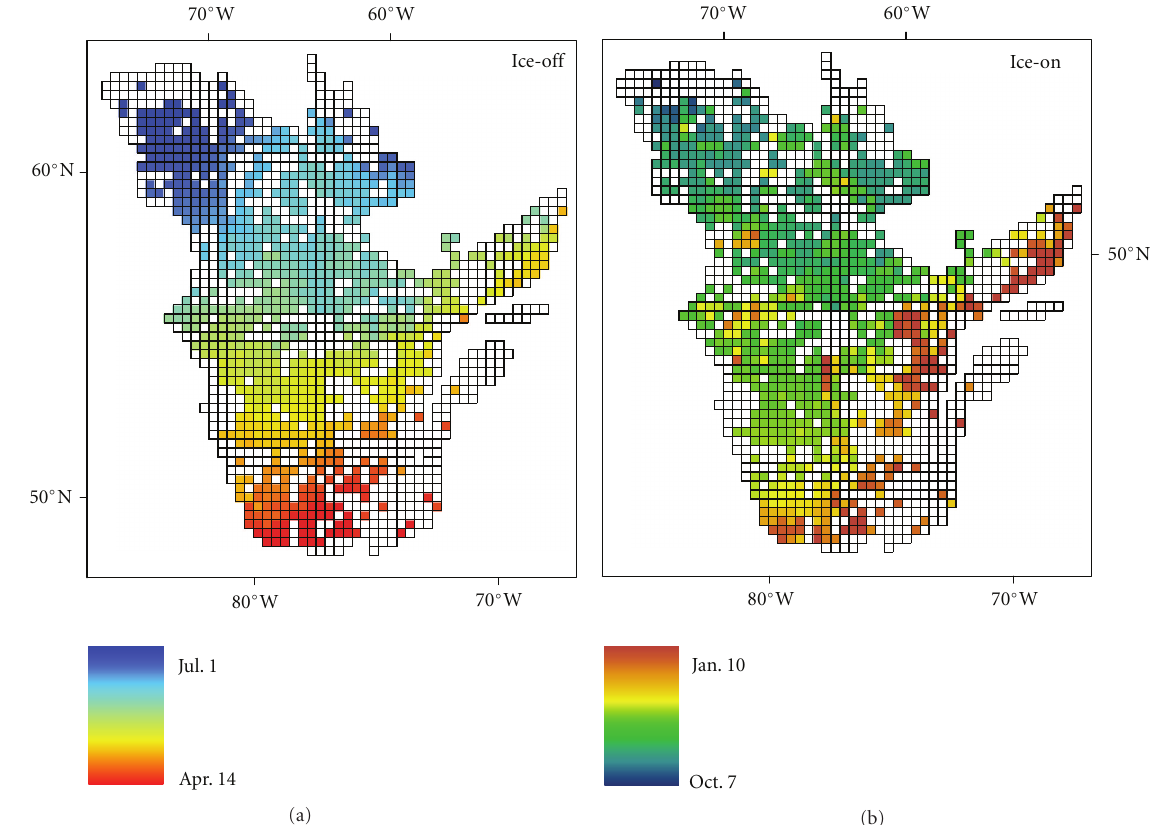
Figure 7: Mean simulated 1981–2010 ice-on and ice-o ff for the province of Quebec. Empty grid cells corresponded to areas where no lakes were identified based on the 500 m resolution MODIS product.